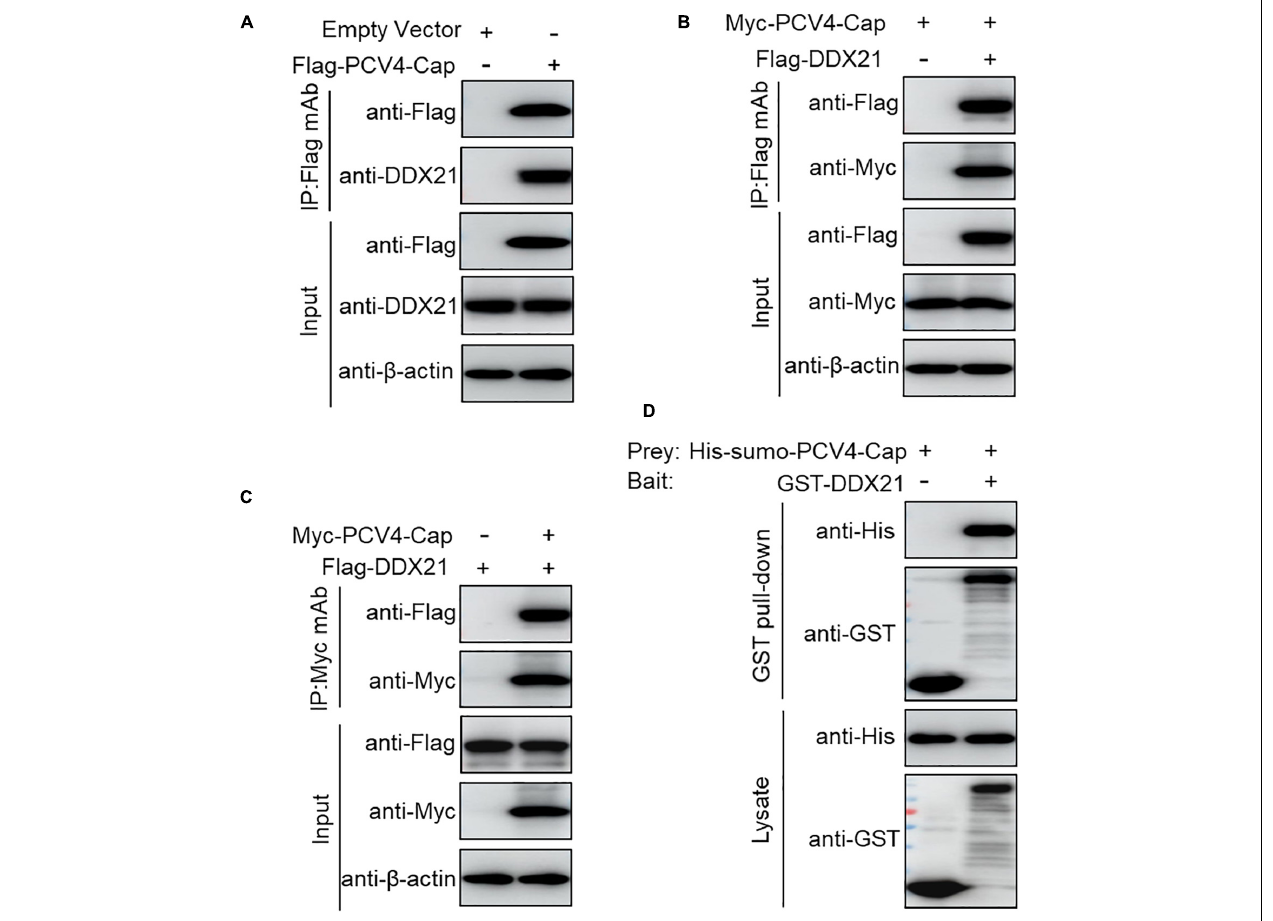
FIGURE 2 | PCV4 Cap binds directly to DDX21. (A) PK-15 cells were transfected with empty vector or Flag-PCV4-Cap plasmid for 48 h. (B,C) The cell lysate extracts were immunoprecipitated with Flag beads (A,B) or anti-Myc purified IgG (C) . (D) The His-sumo-PCV4 Cap mixed with the GST, GST-DDX21 proteins were GST pulled-down and then analyzed by western blotting using corresponding